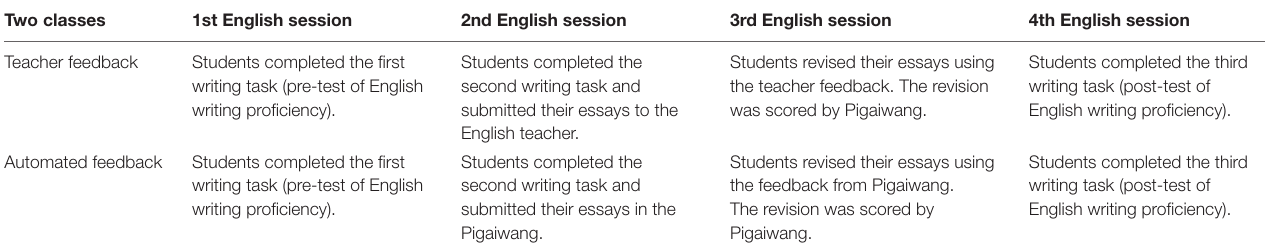
TABLE 2 | Summary of the data collection procedure.